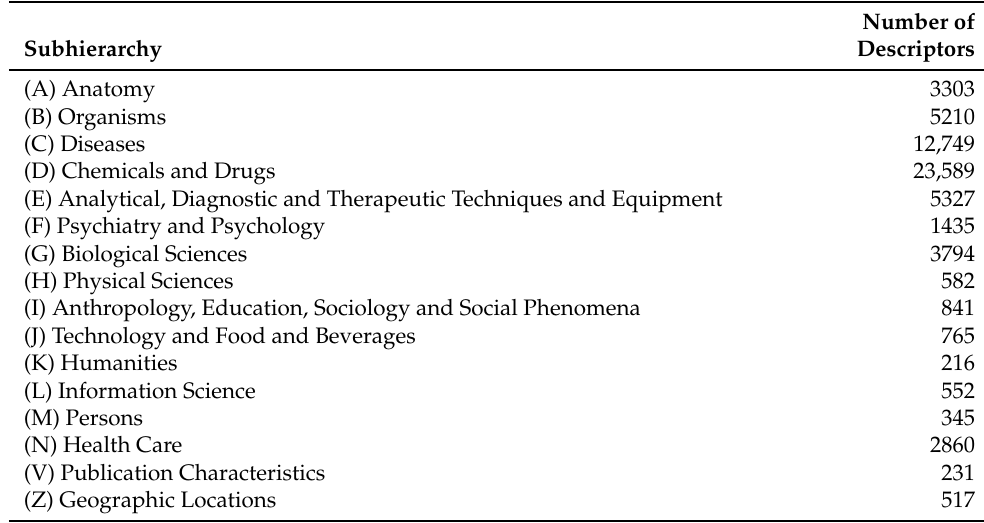
Table 1. Descriptor distribution in MeSH top-level